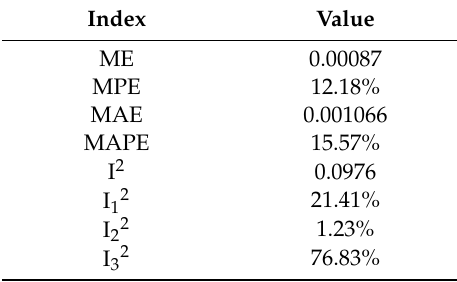
Based on the calculations performed in Table 3 the SHLM percentage error was between 0.0% and 51.72%. These values concern the 10,000 cycle. For the error of the whole model, the mean error (ME), mean percentage error (MPE), mean absolute error (MAE), mean absolute percentage error (MAPE) and Theil index values are presented in Table 4.